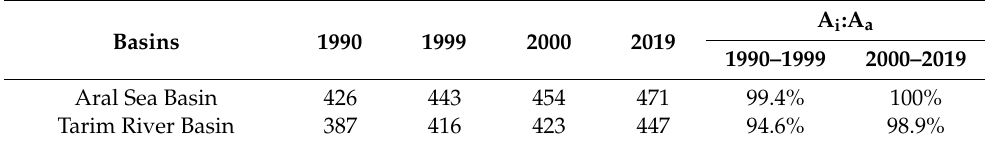
Table 2. Changes in the actual evaporation (ETa, unit: mm) in the Aral Sea Basin and the Tarim River Basin, Central Asia, over different periods before and after